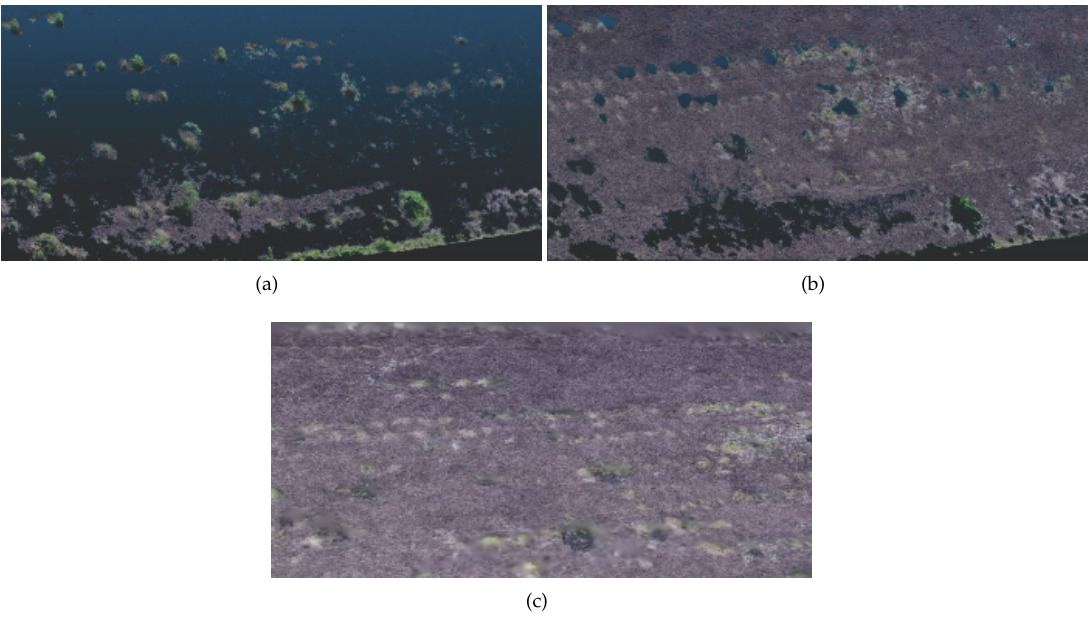
Figure 11. Results of the Algorithm on a Water Dam. ( a ) Vegetation. ( b ) Underlying soil. ( c ) Poisson surface reconstruction.